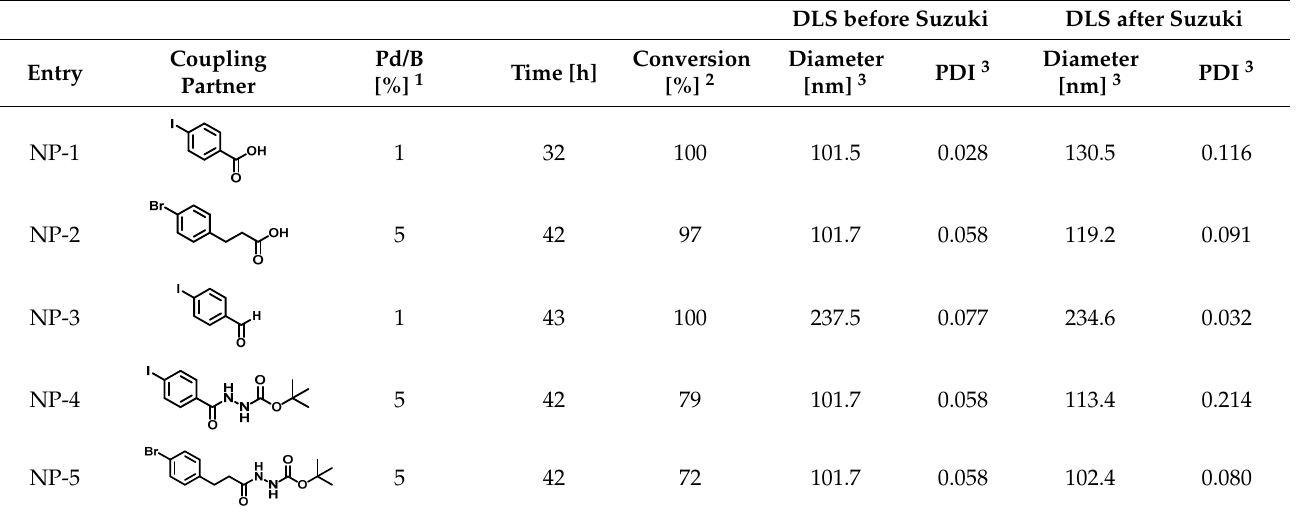
Table 2. Modification of PBANP via aqueous Suzuki–Miyaura coupling reaction.